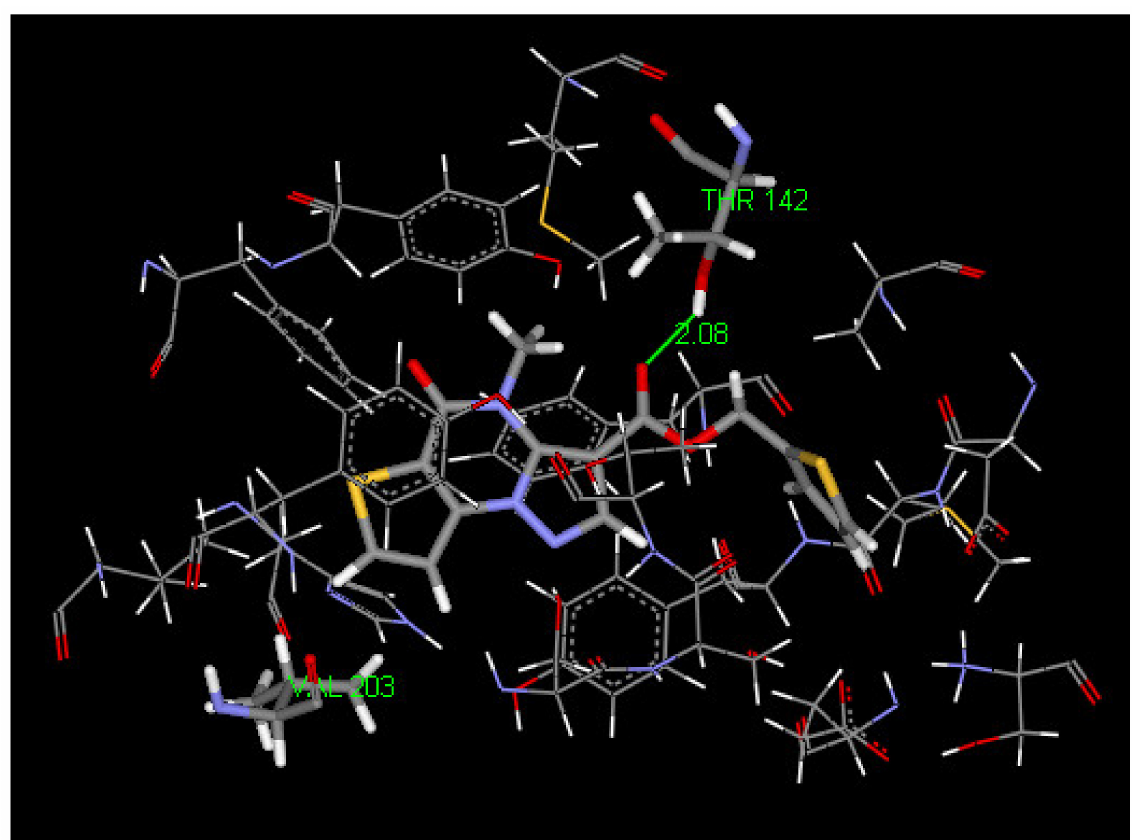
Figure 7. Hydrogen bond interaction of compound 22b in the last frame of dynamic simulation.